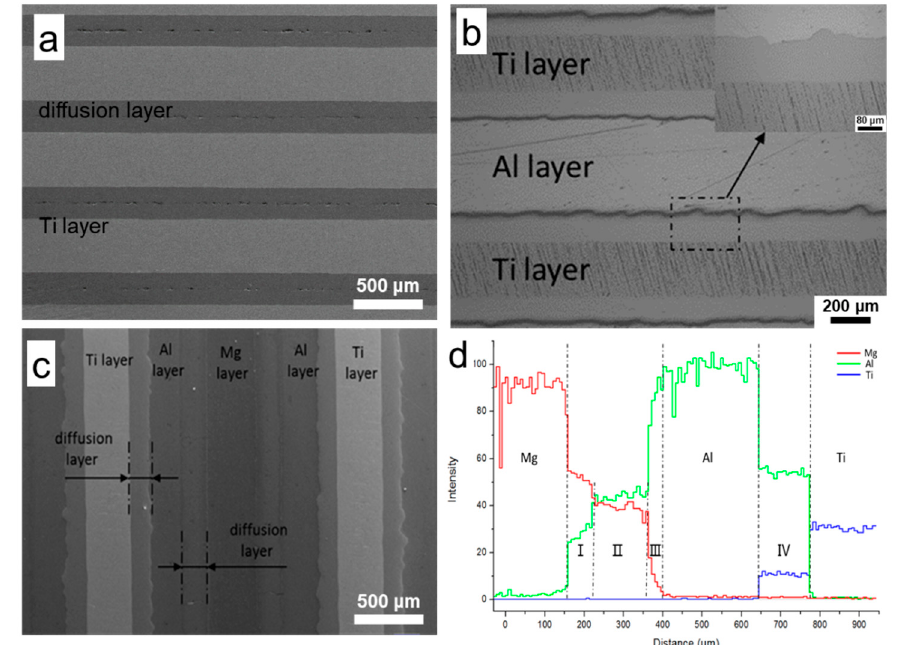
Figure 2. Interface morphology and element distribution of AlTi-based and AlMgTi-based MIL composites: ( a ) The secondary electron SEM image of AlTi-based MIL composites; ( b ) The OM image of Al / Ti / Al prepared in the first stage of the reaction; ( c ) The secondary electron SEM image of AlMgTi-based MIL composite prepared by dual-steps hot pressing process; ( d ) The element distribution lines in the area shown in the red line segment in figure (c).